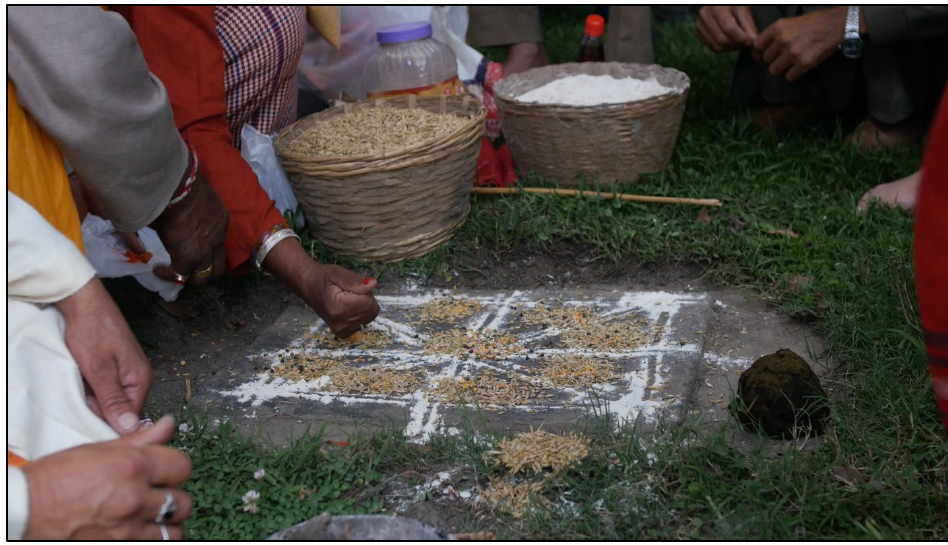
Figure 2. Empowering the yantra (Kahika Kharerna).